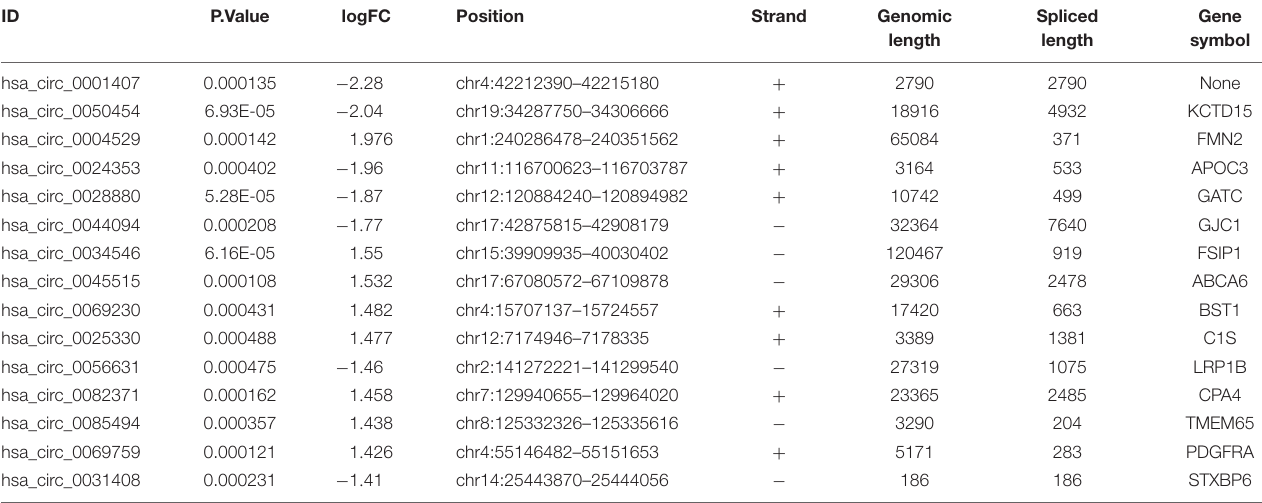
TABLE 1 | Annotation of the top 15 differentially expressed